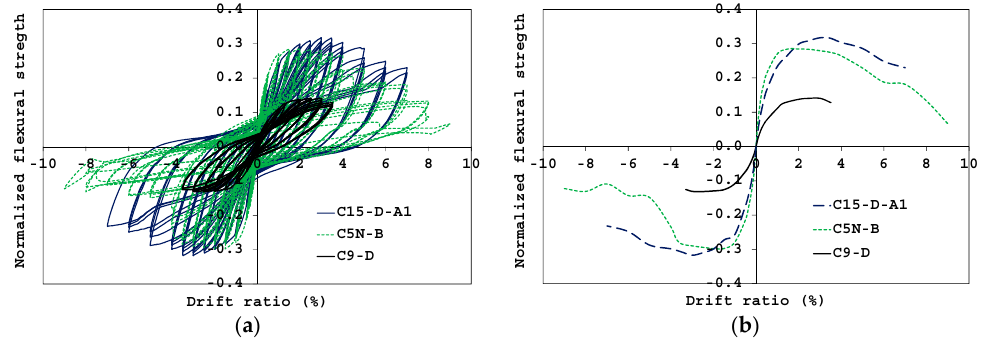
Figure 12. Normalized cyclic ( a ) and envelope ( b ) F ‒δ curves for specimens subjected to ν = 0.14.